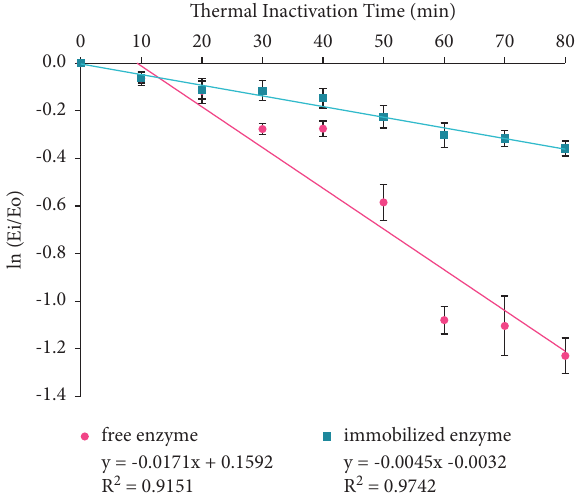
lized enzymes. The data are presented as mean ± SD; n � 2; p ≤ 0 . 05. The error bars represent standard deviations from two replicates measurements.